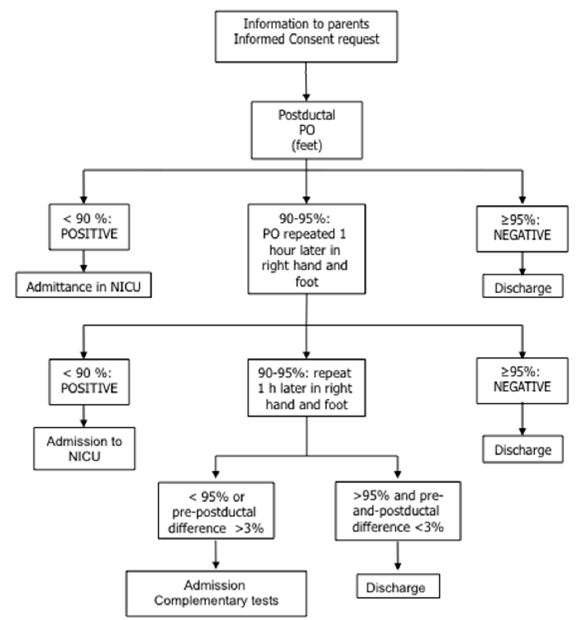
Figure 1. Flow diagram describing the protocol of the Pulsimat study for the screening of critical congenital heart disease. PO: pulse oximetry.